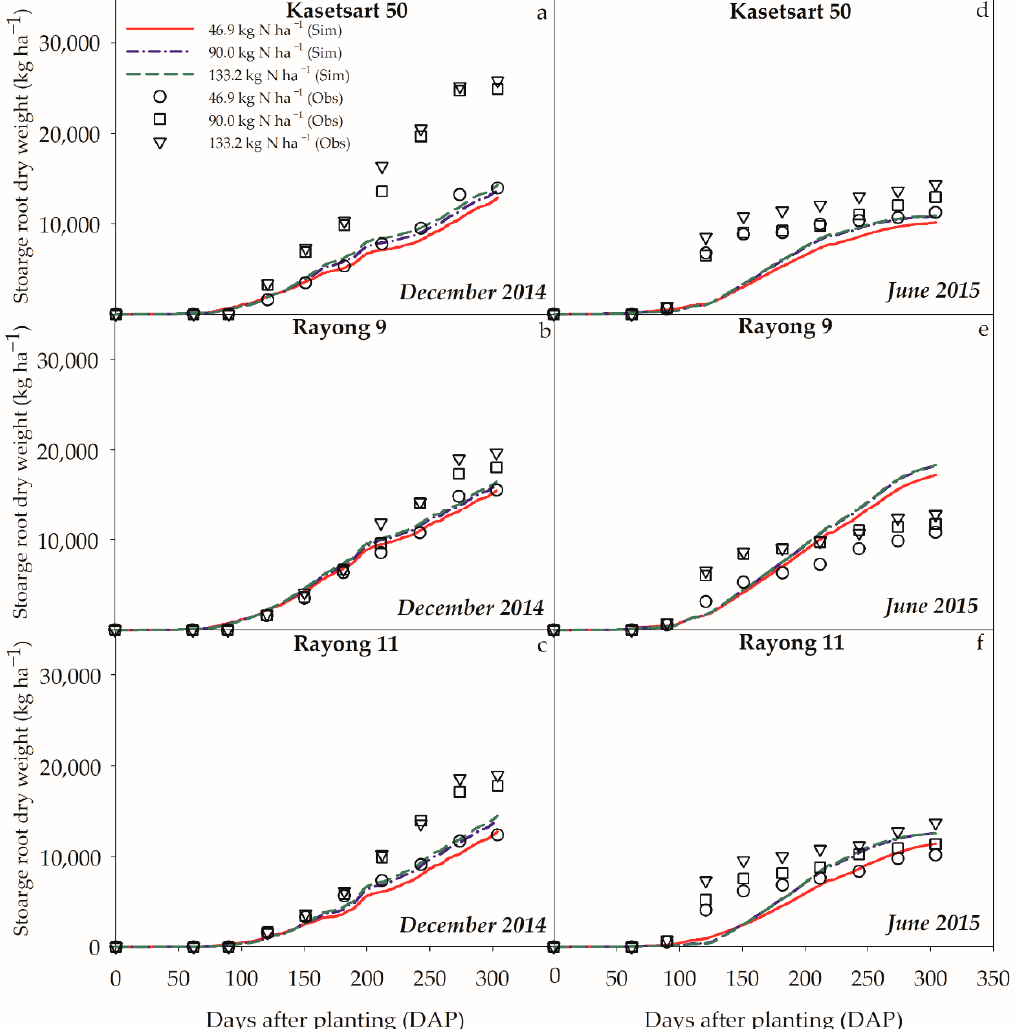
Figure A2. Simulated (Sim) and observed (Obs) storage root dry weights for Kasetsart 50, Rayong 9, and Rayong 11 genotypes planted under three different rates of nitrogen application on December 2014 ( a – c ), and June 2015 ( d–f ).